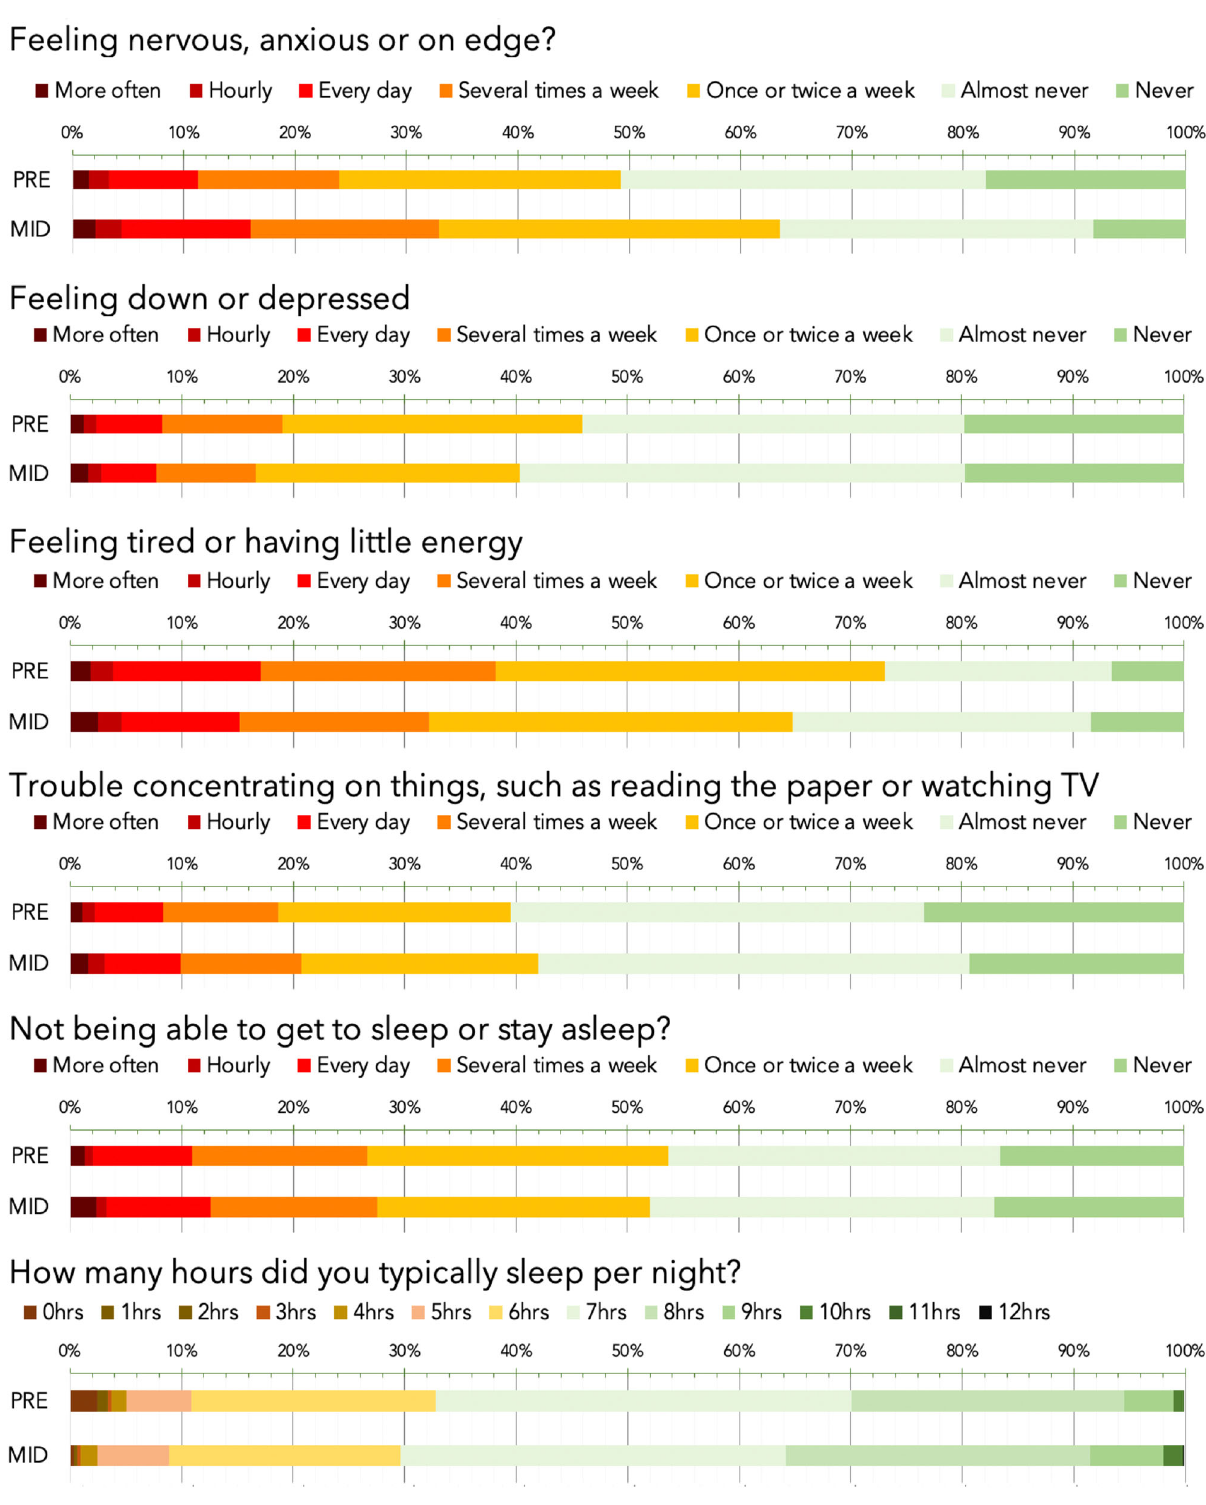
Fig. 2 Visual comparison of mental health and sleep measures during the pre-UK pandemic and mid-UK lockdown epochs. Symptoms of mood and sleep problems, as quanti fi ed using standard mood self-assessment items, in the population for pre-pandemic (pre) and mid-pandemic (mid). Bars in the top fi ve plots represent the percentage of respondents reporting symptoms at different frequencies over recent weeks. The lower plot reports percentage for typical number of hours slept. On average, anxiety levels were higher and people were sleeping more, whereas other mood symptoms were marginally lower. Source data are provided as a Source data fi